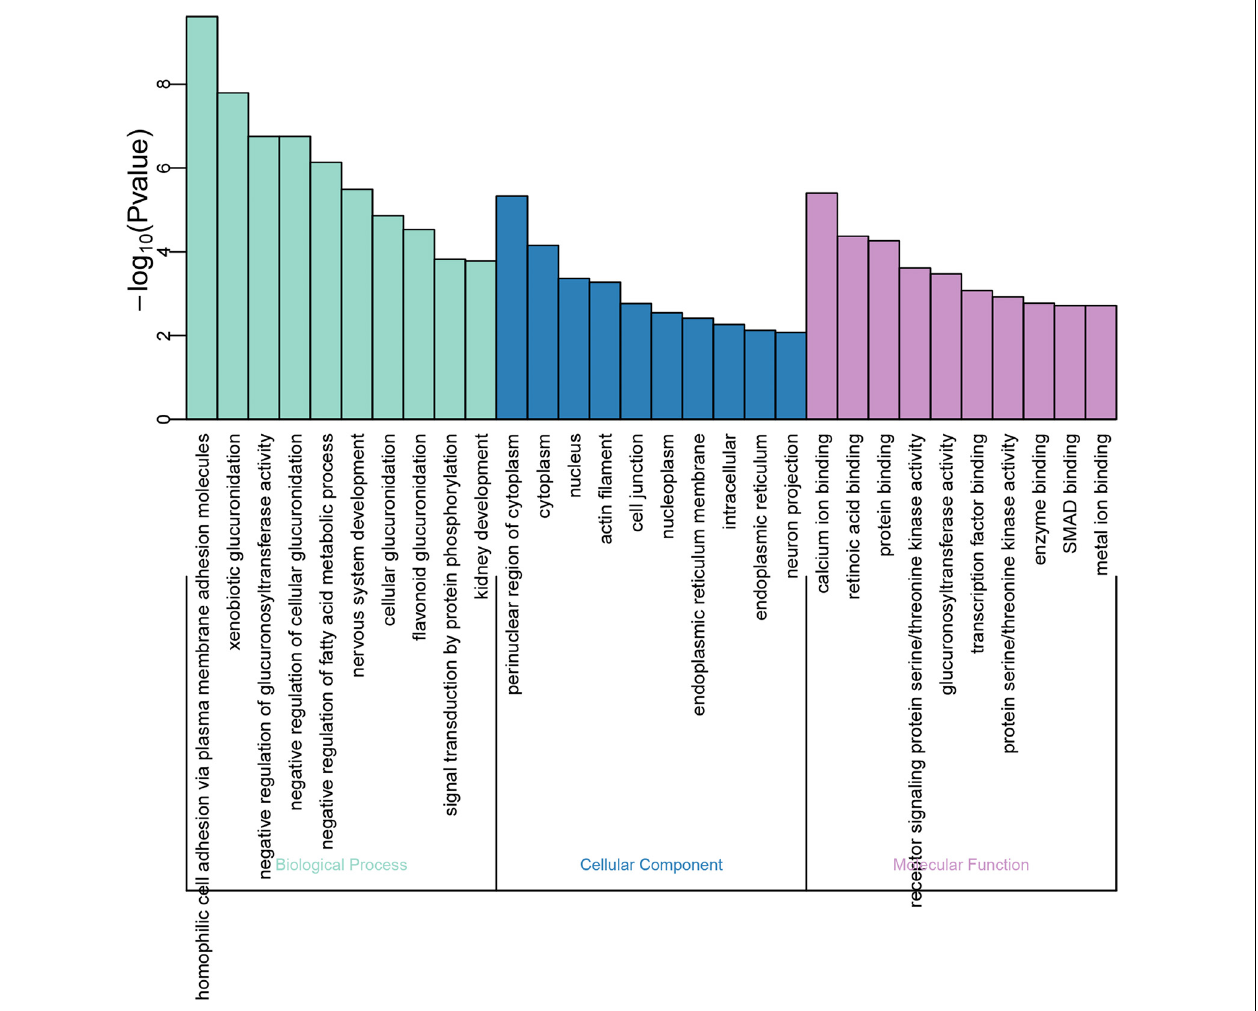
FIGURE 5 | GO function annotations of the downstream target genes. The green bar chart illustrates the biological process, the blue bar chart expounds the cellular component, and the purple bar char interprets the molecular function.